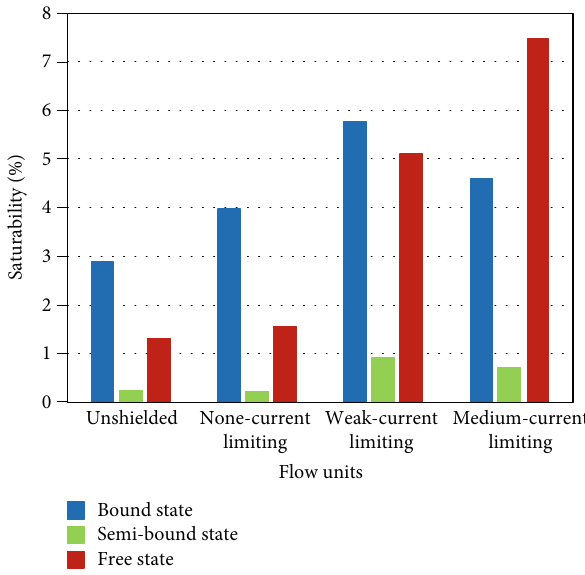
Figure 22: Histogram of saturability as a function of di ff erent fl ow units and types of remnant